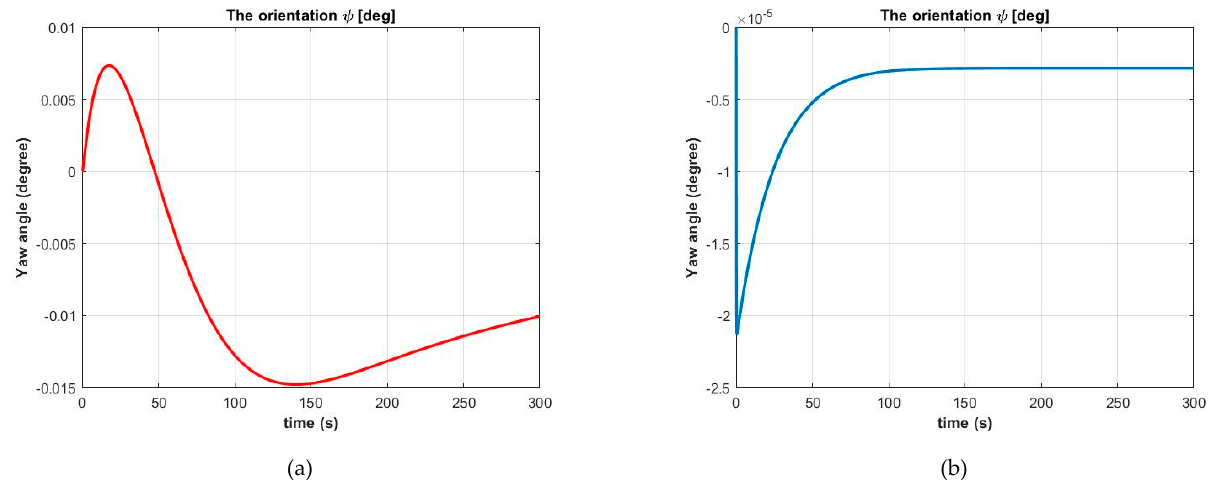
Figure 2. The comparative results of the two methods between ( a ) [37] and ( b ) our proposed